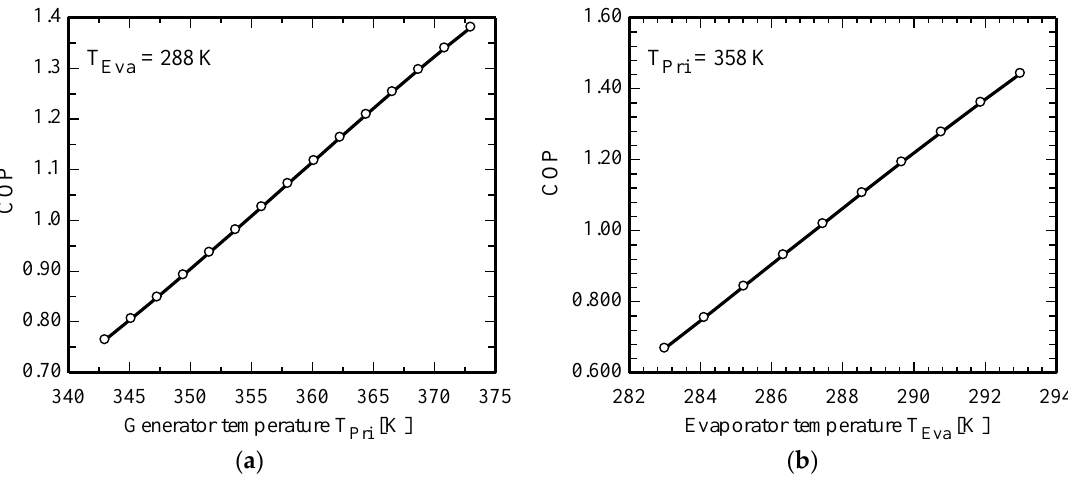
Figure 14. The figure ( a ) depicts the influence of T Eva on system coefficient of performance (COP). The